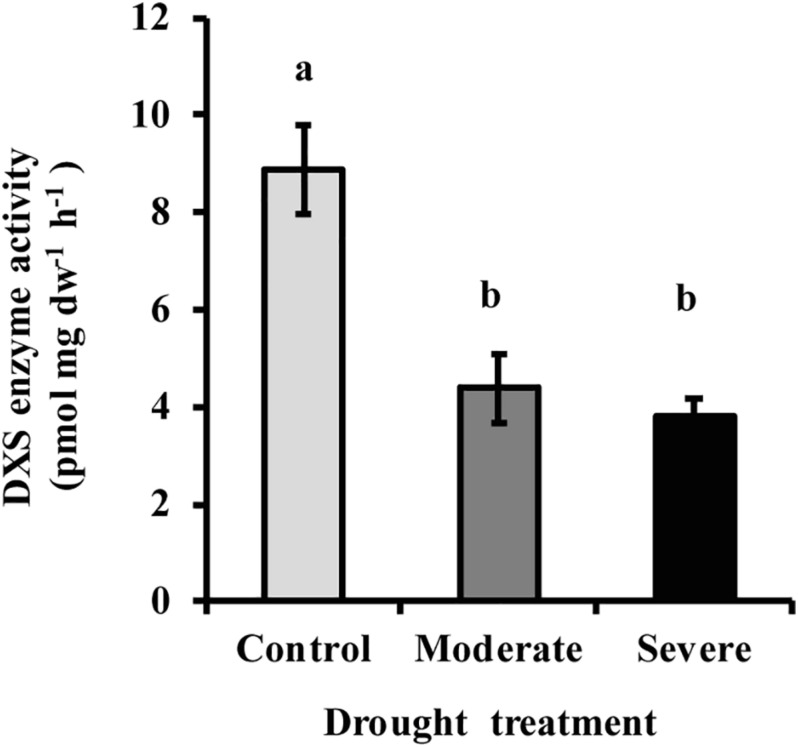
Drought treatment caused a decline in the activity of DXS measured in vitro in extracts of white spruce needles. Data shown are means of three biological replicate ± SE. Different letters indicate significant differences at P < 0.05.